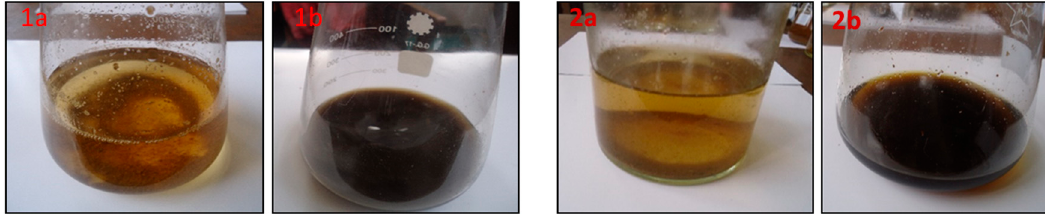
Figure 2. Cell suspension from callus through somatic embryogenesis using LS after 7 days ( 1a , 2a ) and the end of induction (40 days) ( 1b , 2b ) in ( 1 ) T. vulgaris and ( 2 ) O. basilicum.